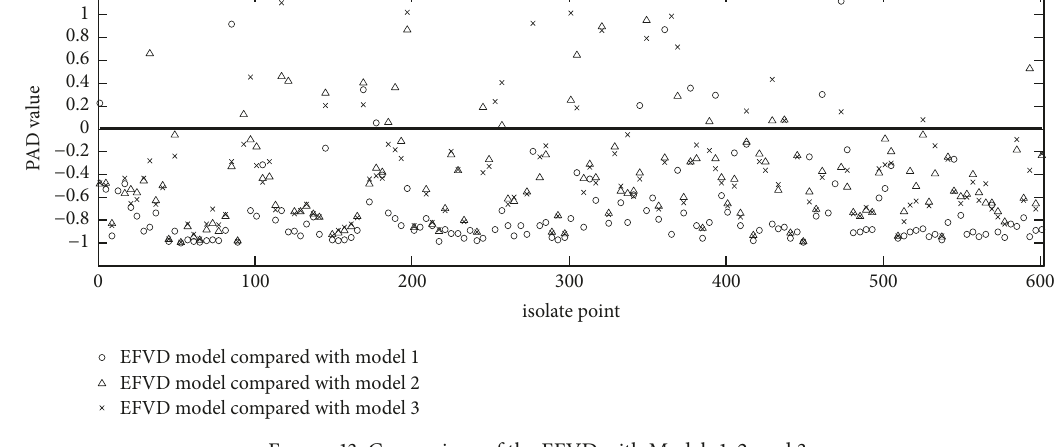
Figure 13: Comparison of the EFVD with Models 1, 2, and 3.